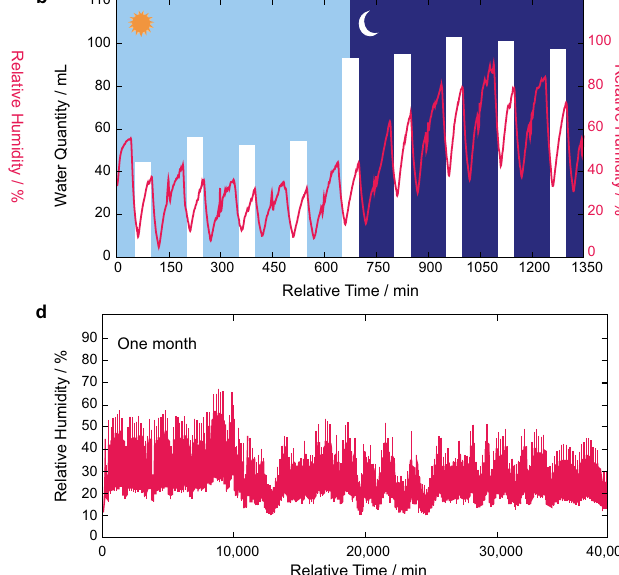
performanceforoneweek. d Monitoringthecondensationcompartmentresponse to demonstrate the adaptive device ’ s performance for one month of continuous operation. All data was collected on the adaptive device after it had performed >1000 cycles, which is equivalent to ca. 1 year of operation. Source data are pro- vided as a Source Data fi